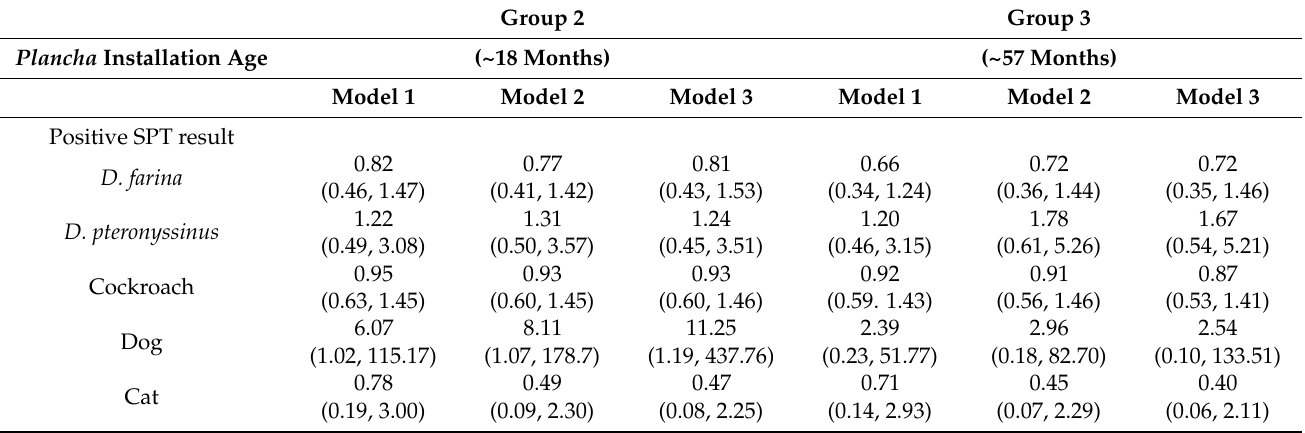
Table 4. Odds Ratios (ORs) and 95% confidence intervals allergic outcomes associated with study